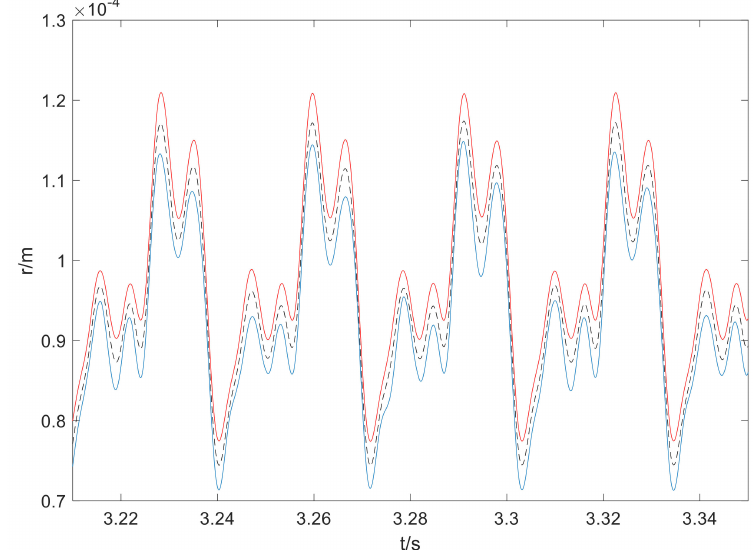
Figure 9. Vibrations of the rubbing rotor with 5% bounded contact sti ff ness uncertainty: blue solid line = lower bound; red solid line = upper bound; black dotted line = deterministic